Question: In one sentence, what is this figure communicating?
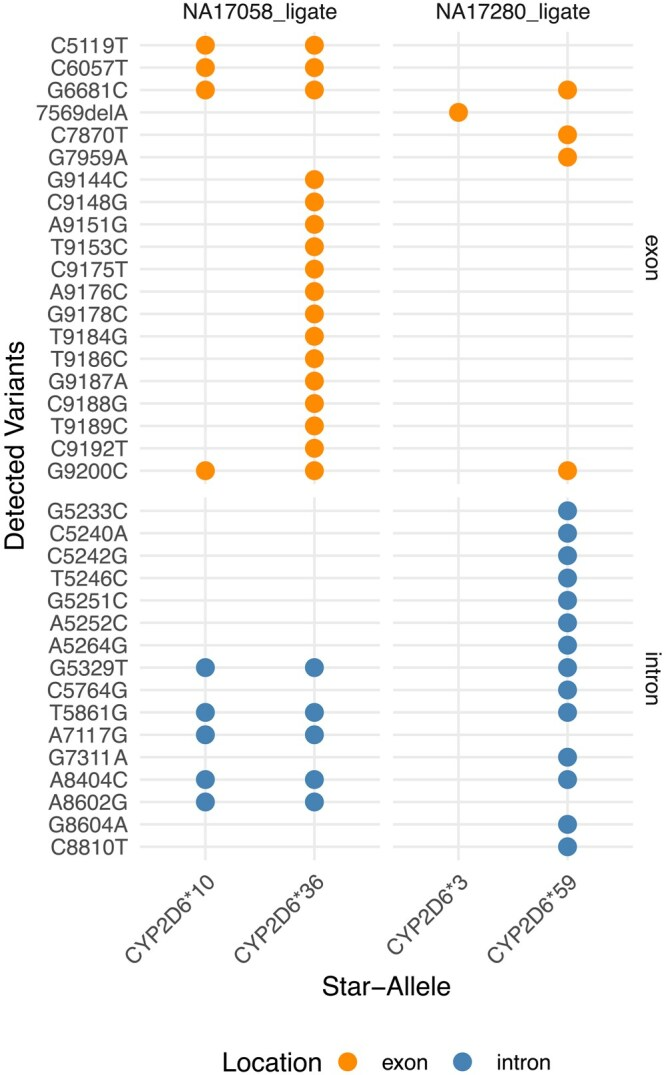
Answer: Landscape of variants identified in reconstructed alleles for NA17058_ligate and NA17280_ligate. In each sample, two alleles were reconstructed. Exonic variants are displayed as orange bubbles, intronic variants as blue bubbles. In both samples, the supported alleles differ by a large number of variants, and do not have significant overlap with each other.